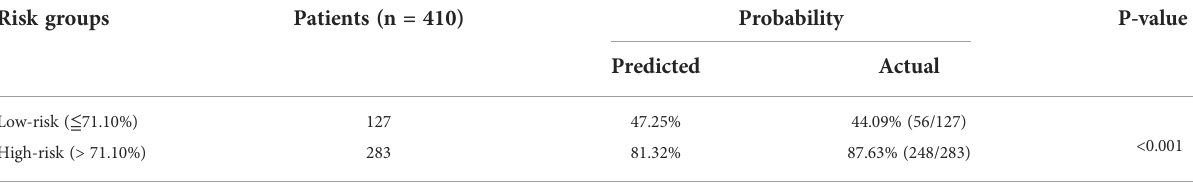
TABLE 5 Risk strati fi cation among patients in the internal validation cohort.